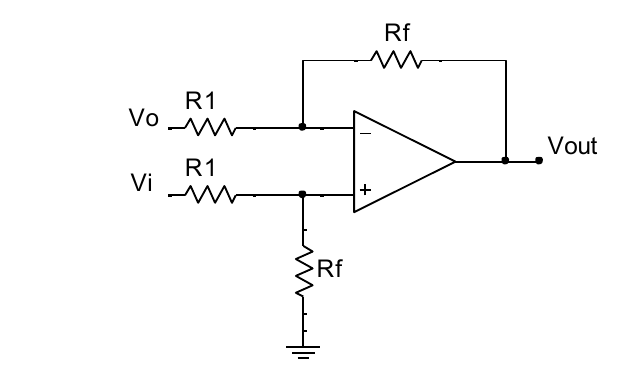
Fig. 2. Feedback Mechanical Unit Model 33-100